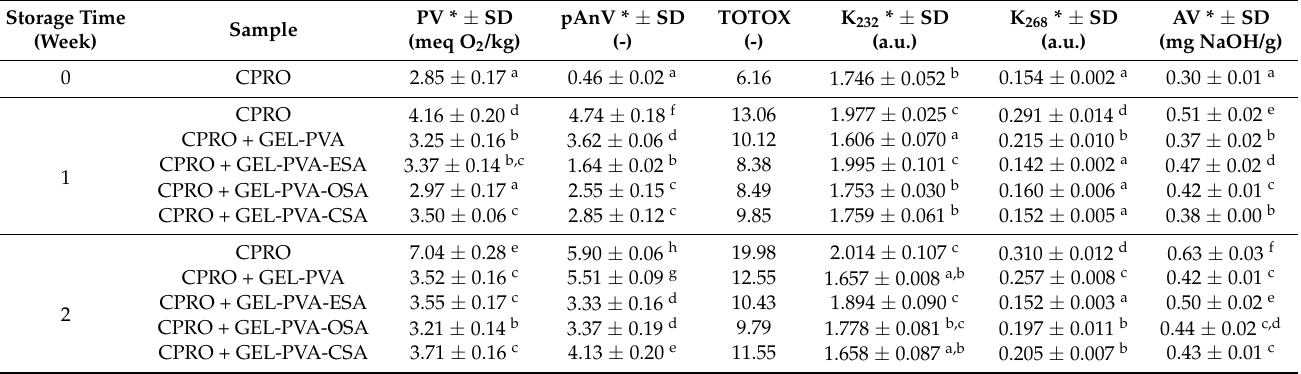
Table 3. Changes in the oxidative status of cold-pressed rapeseed oil without and with GEL-PVA film strips loaded with sinapic acid esters during storage for two weeks at accelerated conditions (T = 40 ◦ C, fluorescent